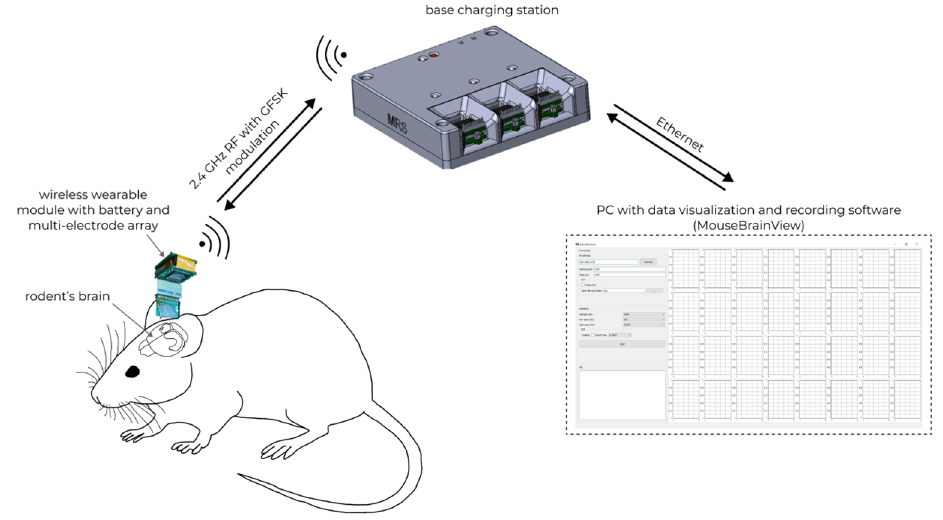
Figure 11. In vivo registration of neural activity in rodents’ brain with wireless electrophysiological complex.